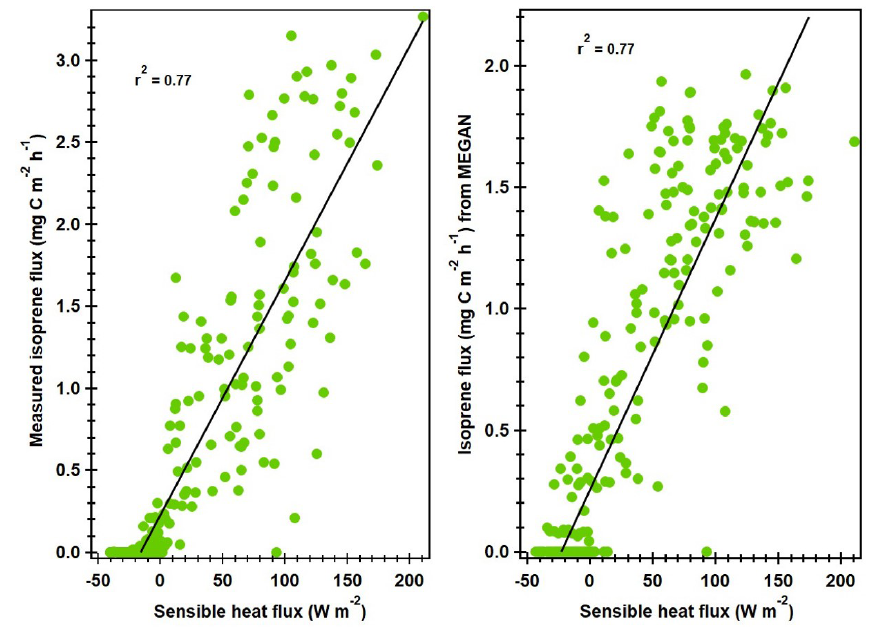
Figure 6. Scatterplots for measured and MEGAN2.1 estimated isoprene flux with measured sensible heat flux.